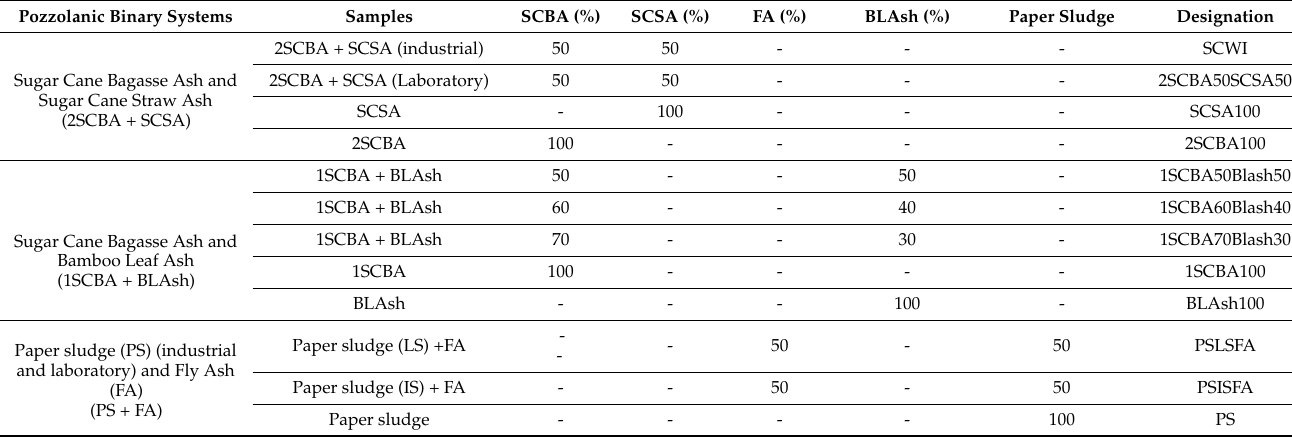
Table 1. Designations of the samples used in the present